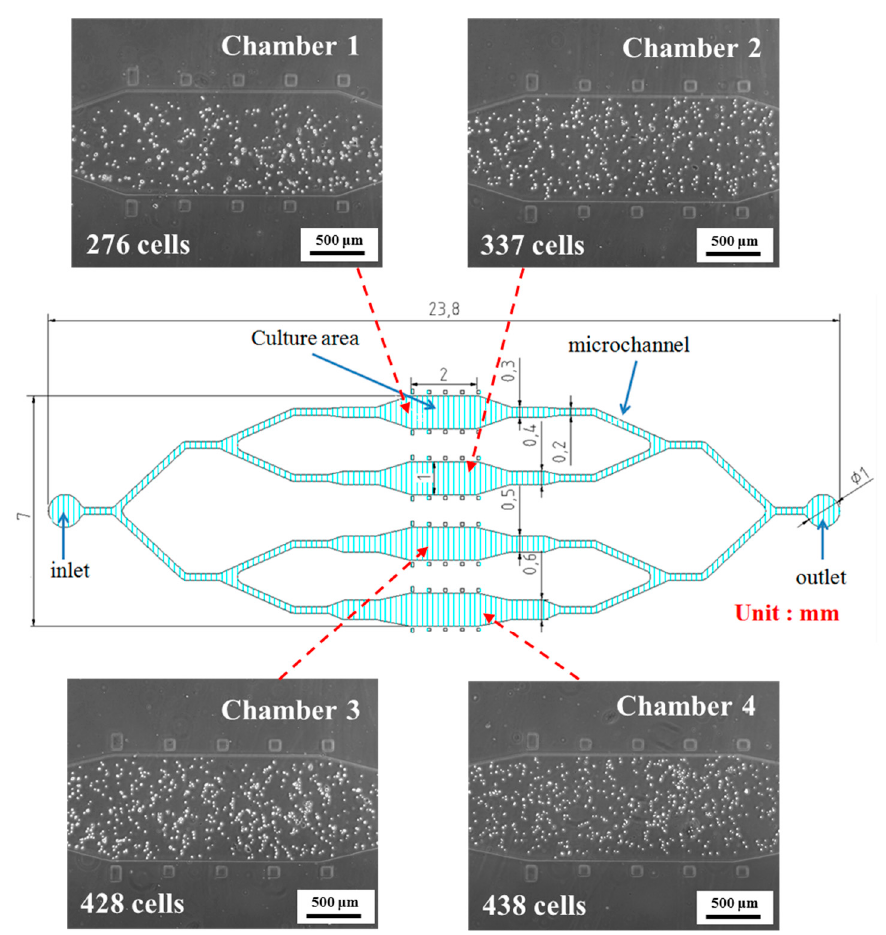
Figure 6. rBMSCs fluid flow shear stress microfluidic chip with different microchannel widths.